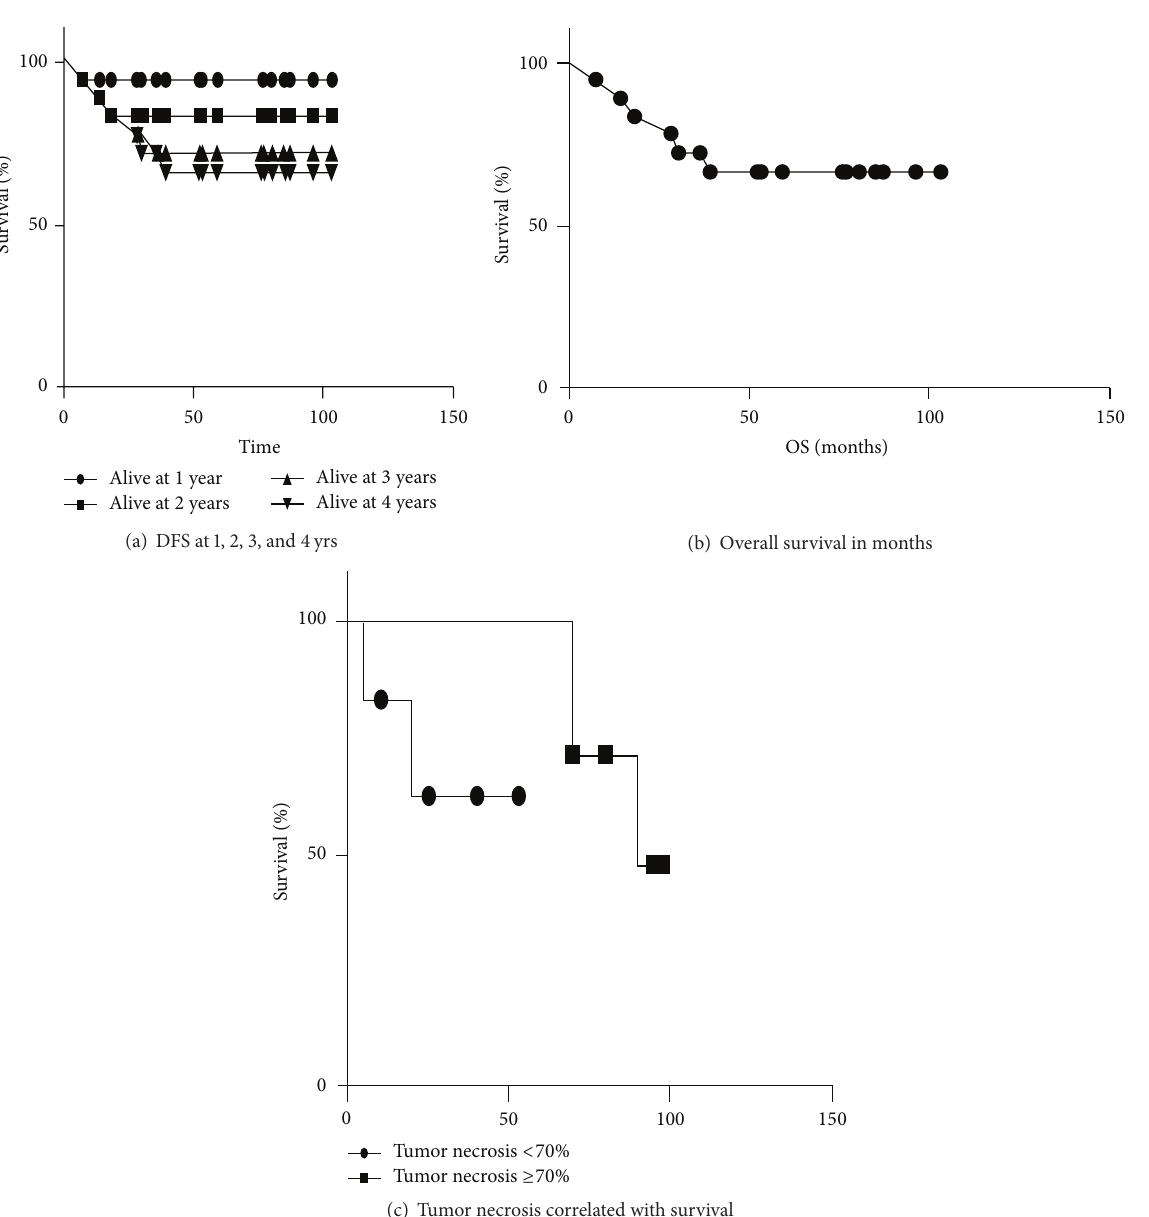
Figure 1: (a) Kaplan Meir curves showing the disease-free survival at 1, 2, 3, and 4 years (94%, 83%, 72%, and 66%, resp.) of patients who received neoadjuvant intratumoral injection of dendritic cells and radiation in high-grade soft tissue sarcomas over 5 cm. (b) Kaplan Meir curve showing overall survival of patients in months on patients who received neoadjuvant intratumoral injection of dendritic cells and radiation in high-grade soft tissue sarcomas over 5 cm. (c) Kaplan Meir curves showing tumor necrosis less than 70% or ≥ 70% in patients who received intratumoral dendritic cell injections followed by radiation and then surgery with resection of tumors to determine the percentage of necrosis after surgery 𝑝 = 0.76